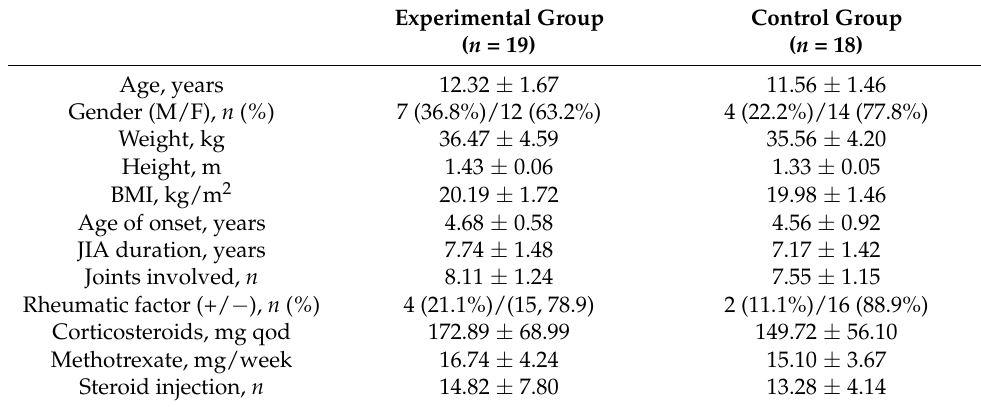
Table 2. Demographic and clinical characteristics of children in the IMT and control groups.